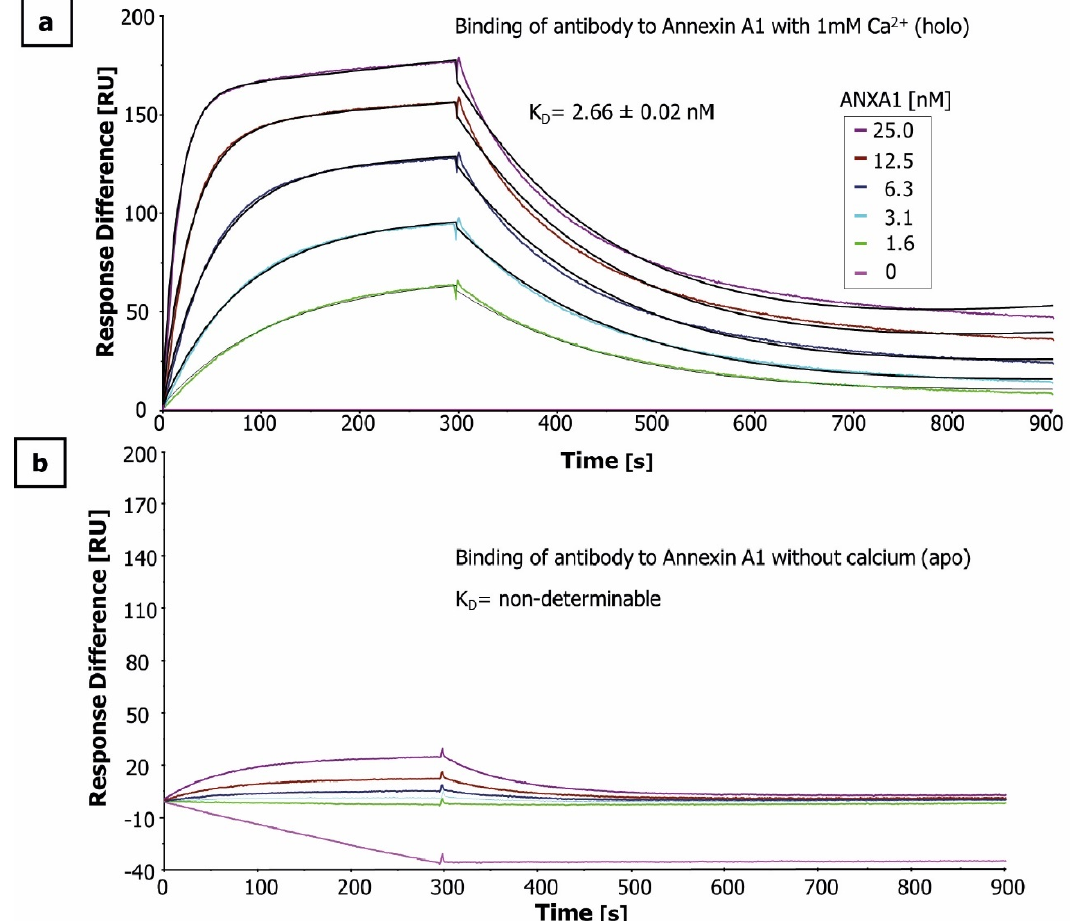
Figure 1. Binding affinities of anti-ANXA1 antibody. For surface plasmon resonance spectroscopy (SPR)-based affinity measurements, anti-ANXA1 antibody was immobilized via a covalently coupled anti-human IgG on a CM5 chip. Kinetic measurements were performed by injecting five concentrations of ANXA1 in presence and absence of calcium (holo ( a ), and apo ( b ), respectively) ranging from 1.6 to 25 nM. The obtained datasets were evaluated using the 1:1 Langmuir binding model. All measurements were performed in triplicate. Only one representative sensorgram is shown. The equilibrium dissociation constant in presence of calcium was determined to be 2.66 ± 0.02 nM, whereas the antibody did not bind to ANXA1 in the apo-state.